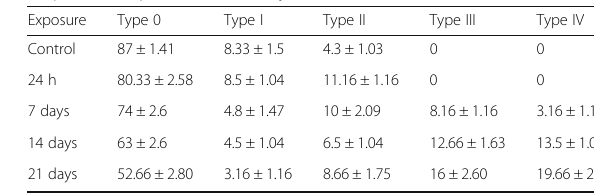
Table 2 Nucleoids in various damage degrees in the liver of C.